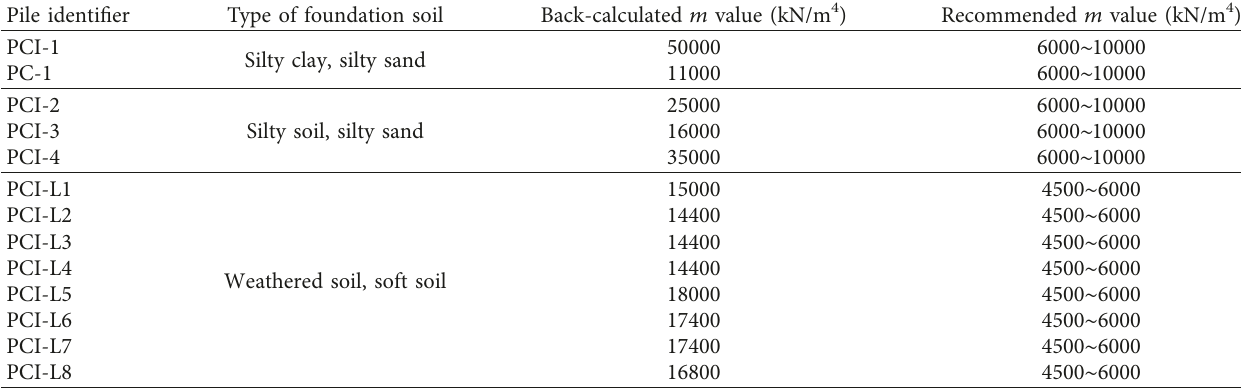
Table 5: Back-calculated and recommended m values at a pile-head deflection of